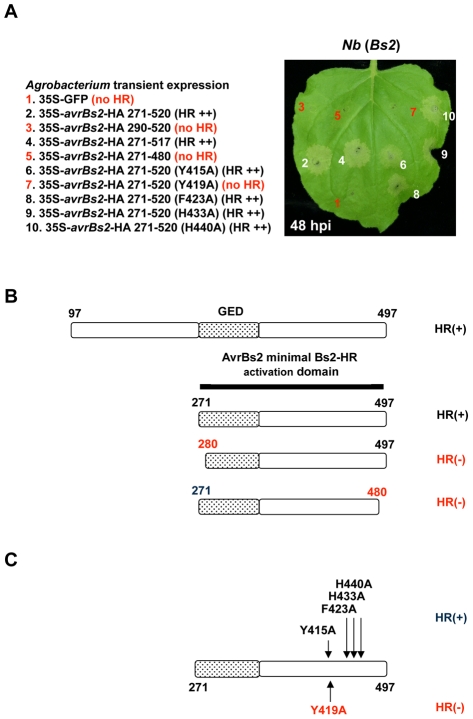
Characterization of the minimal AvrBs2 domain required for Bs2 activation.
A. Various AvrBs2 deletions and mutations of the minimal AvrBs2 domain required for Bs2 activation are expressed by the 35S promoter transiently on Bs2 Nicotiana benthamiana by Agrobacterium (48 hpi at 3×108 CFU/ml). B. AvrBs2 coding region map with numbers representing amino acid positions. Deletion analysis defined AvrBs2 amino acids 271–520 as the minimal domain for Bs2-activation. In Supplemental Figure S3B we confirm the HR response of these AvrBs2 clones on Bs2 pepper. Also we detect similar protein expression for all clones using C-terminal HA epitope tags and immunoblot analysis (Supplemental Figure S3A). C. Mutational analysis of the C-terminal region of the minimal Bs2-HR activation domain. Single amino acid mutations identify amino acid Y419 as needed for BS2 activation. In Supplemental Figure S3B we confirm the HR response of these AvrBs2 clones on Bs2 pepper. Also we detect similar protein expression for all clones using C-terminal HA epitope tags and immunoblot analysis (Supplemental Figure S3A).